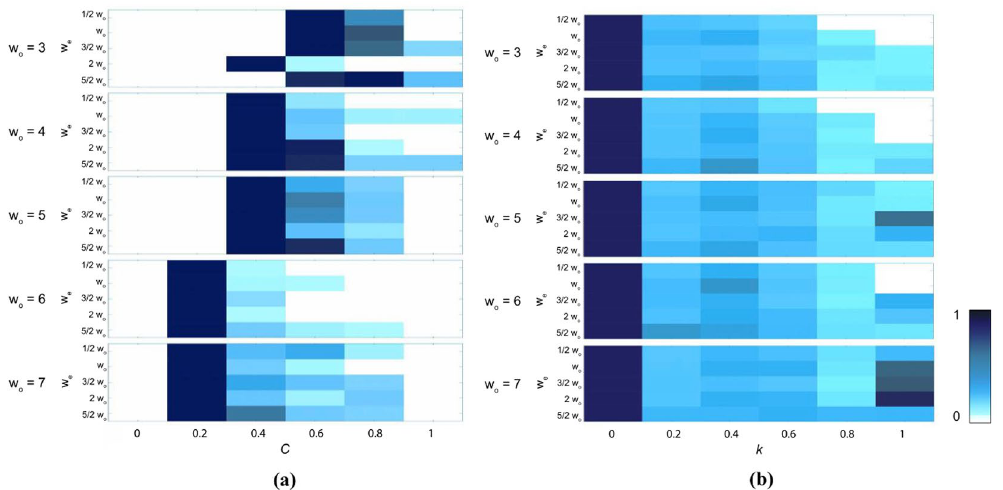
Figure 8. Heat maps of compression C (left) and Lyapunov exponent values k (right) for all state trajectories of sampled o for Case I CA. From top to bottom w o = 3, 4, 5, 6 and 7, with distributions shown for = w w 5 , 2 w o and w (from top to bottom in each panel, respectively) for each w o . Distributions are normalized to w o 3 o 2 2 the total size of sampled trajectories for each w o and w e (see statistics in Table